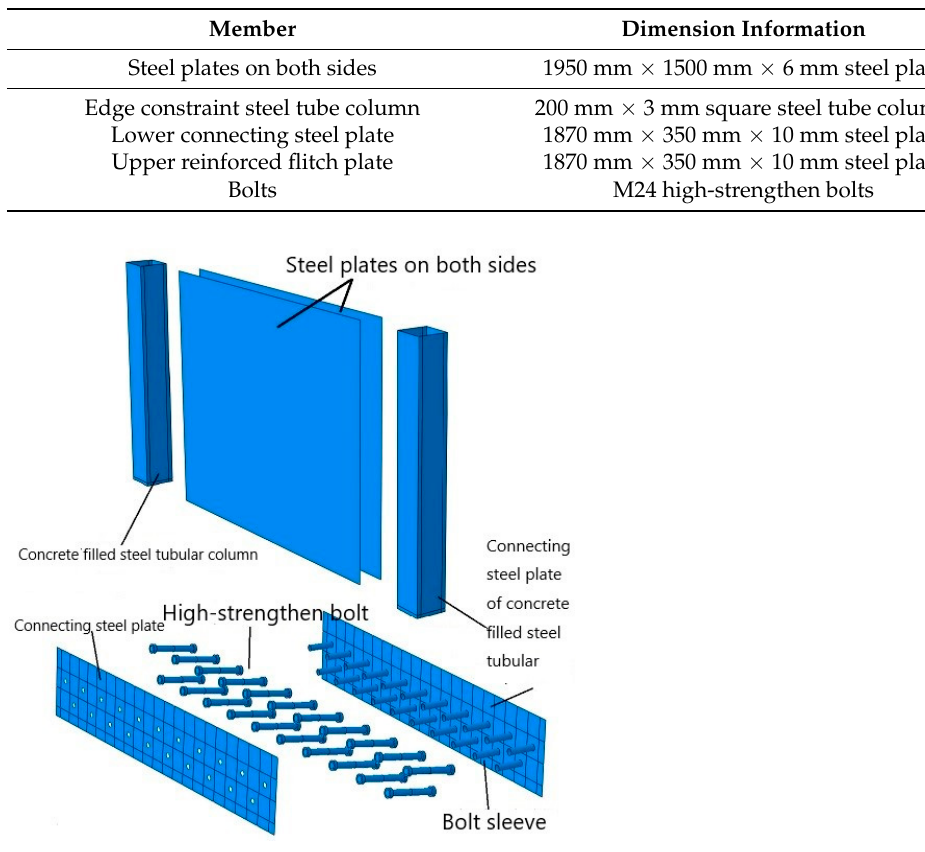
Table 1, and the model explanation of each member in the upper and lower shear wall units is shown in Figures 3 and 4. Table 1. Dimension information of members. Table 1. Dimension information of members.